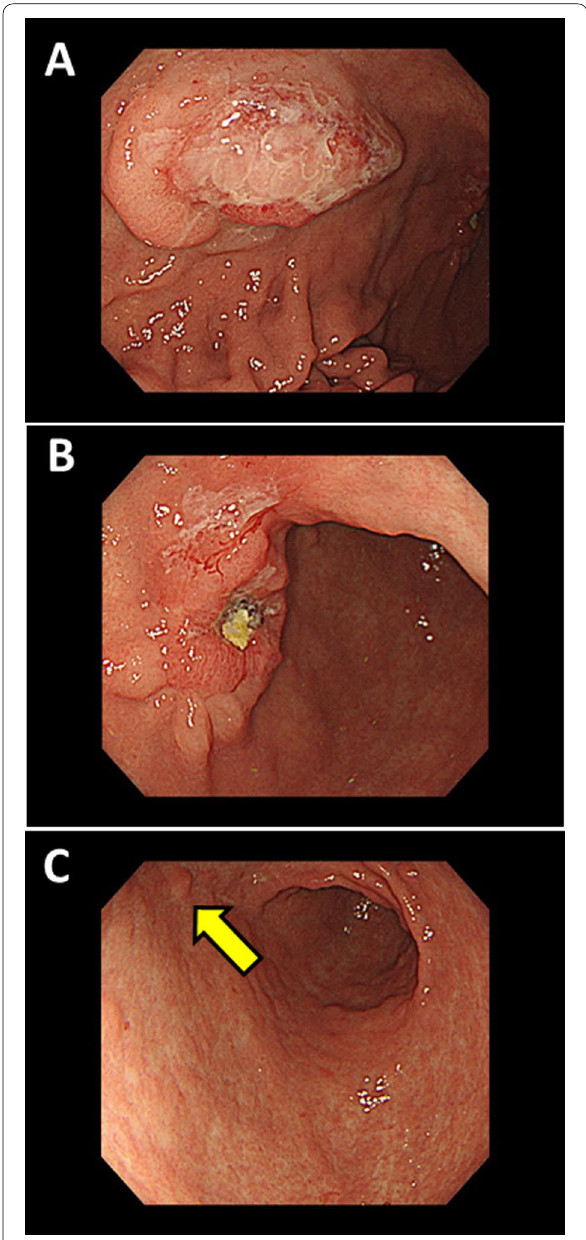
Table 1 Two cases with adenocarcinoma, lymphoma, and GIST in the stomach